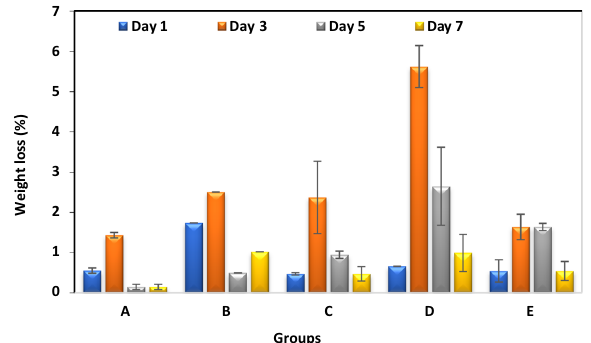
Fig. 8 Water uptake behavior of different groups of arti fi cial teeth with standard deviations error